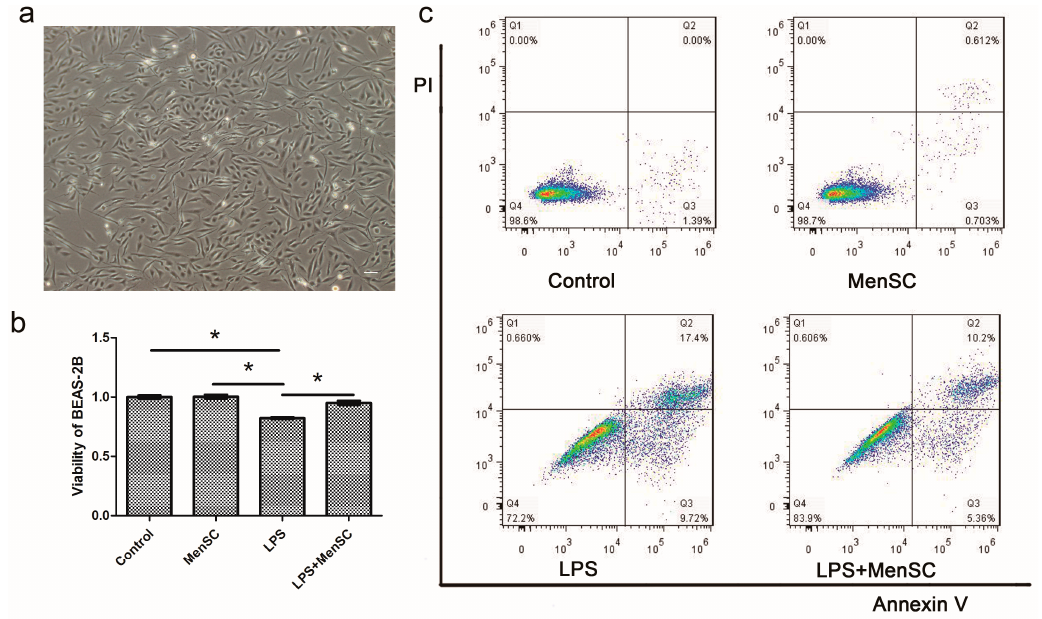
Figure 3. MenSCs protect BEAS-2B cells from LPS injury. ( a ) Morphology of BEAS-2B cells observed by microscopy; ( b ) Viability of BEAS-2B cells in four groups after co-cultured with or without LPS and MenSCs; ( c ) Apoptosis of BEAS-2B cells after co-culture was assessed by Annexin V/PI. Numbers represent the proportion of BEAS-2B in the restricted image. The experiment was repeated triple. PI: Propidium. Iodide * p < 0.05. Scale bar: 50 µm.